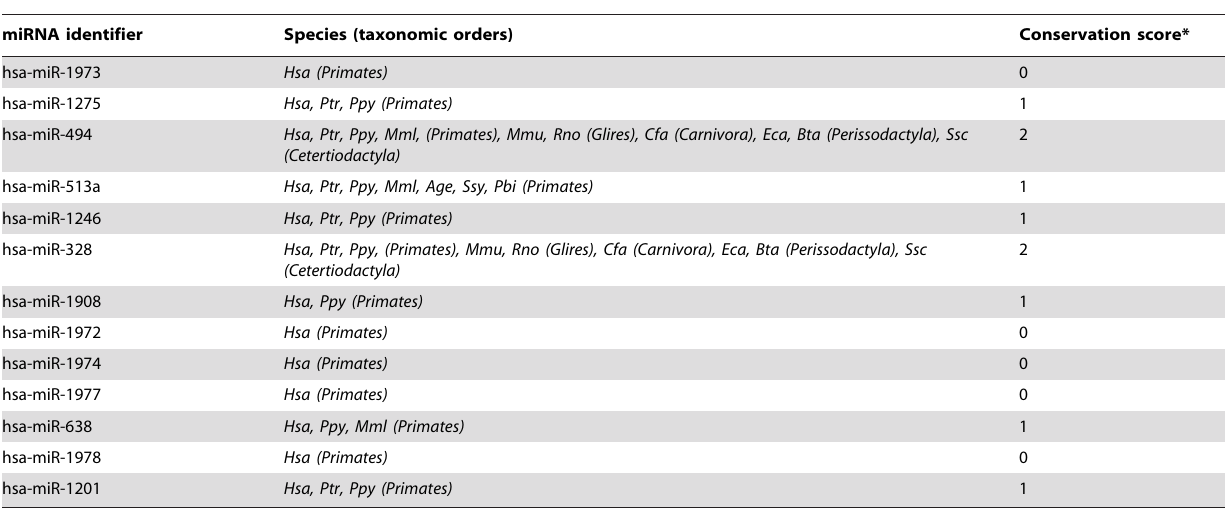
Table 1. Cross-species conservation of pre-miRNA sequences in metazoans.